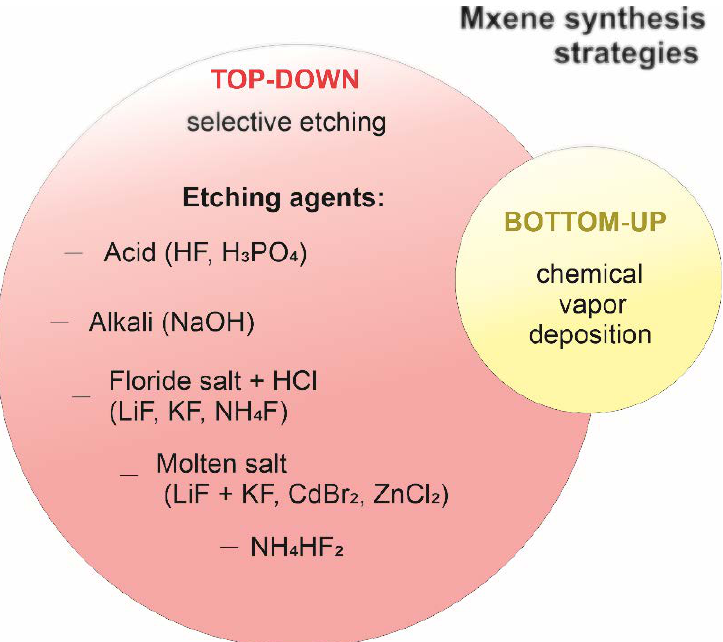
Figure 1. Methods for obtaining MXenes and examples of reagents used for selective etching of MAX phases or other precursor materials.